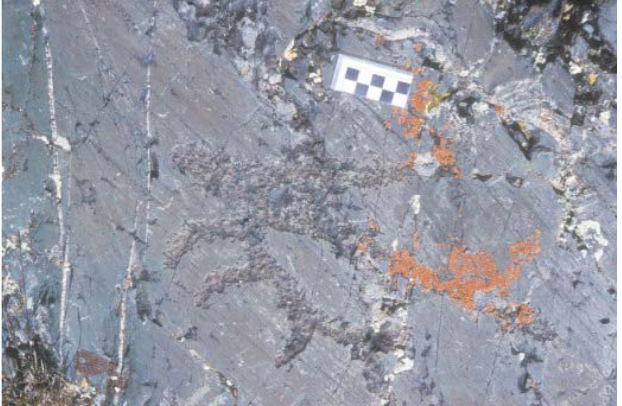
Figure 28. Head of an unfinished elk. Pre-Bronze Age. Upper Tsagaan Gol.